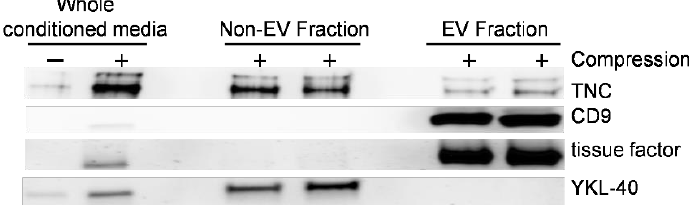
Figure 4. Mechanical compression induces the release of EVs containing TNC from HBE cells. Representative Western blots of four independent experiments show that CD9, tissue factor, YKL-40, and TNC were detected in the whole conditioned media with a greater abundance in conditioned media from compressed cells. YKL-40 was detected in the non-EV fraction, while CD9 and tissue factor were detected in the EV fraction. TNC was detected in both the non-EV and the EV fractions.